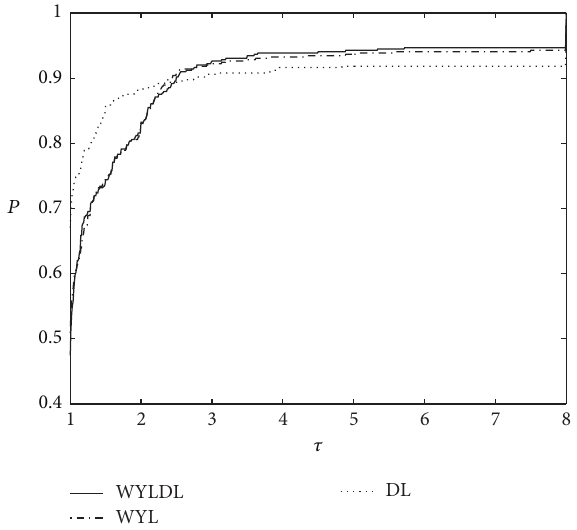
Figure 1: Performance profiles based on iterations.